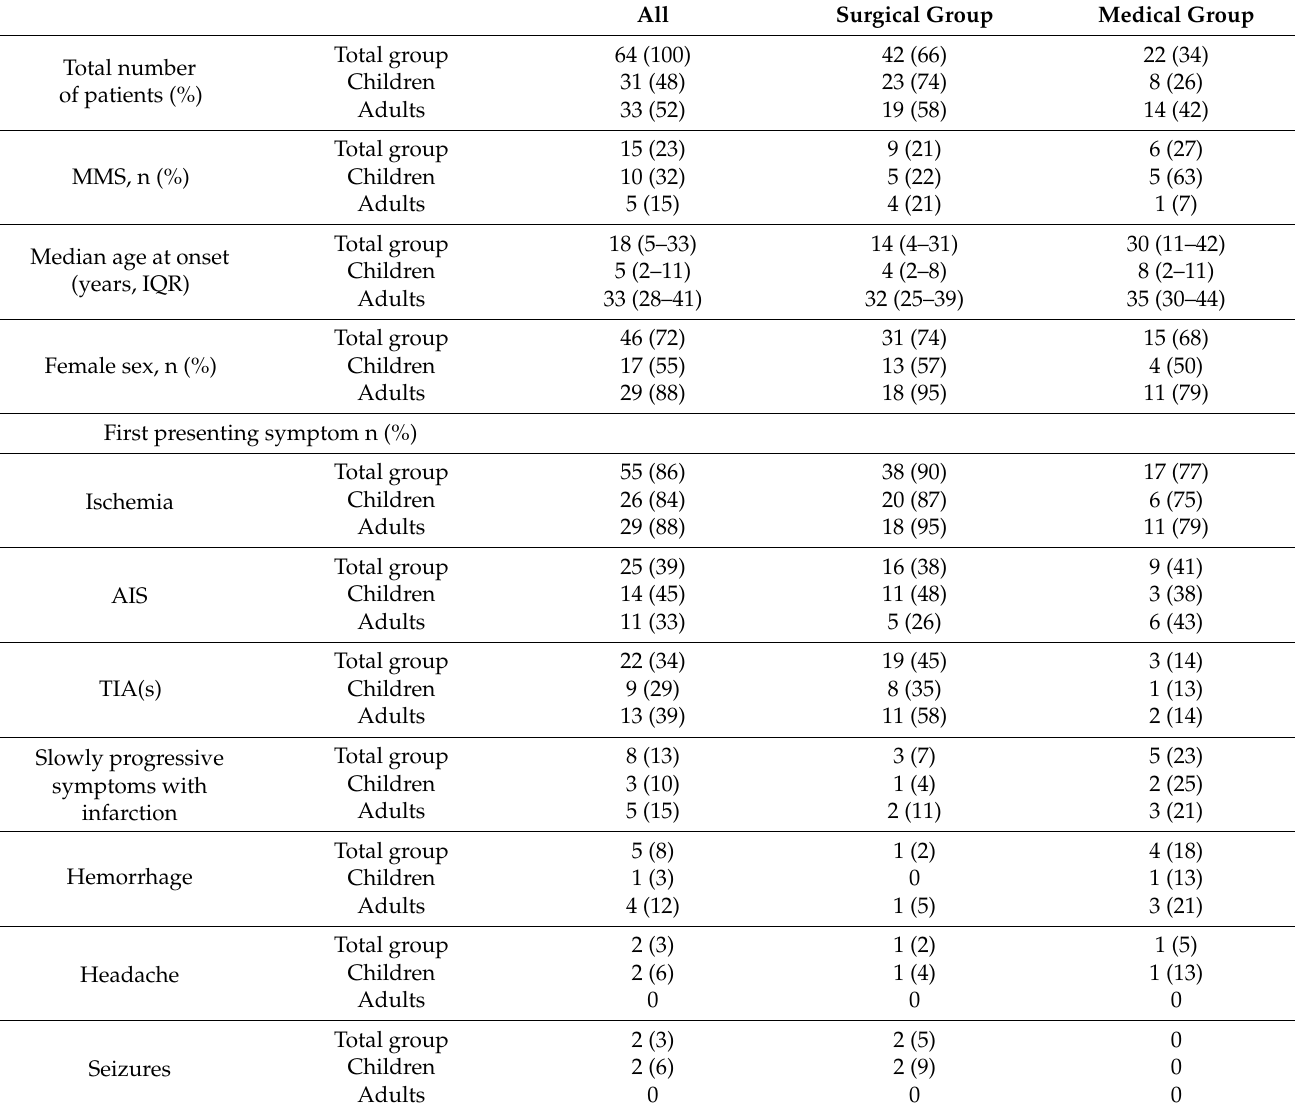
Table 1. Baseline characteristics of 64 patients with moyamoya vasculopathy. All Surgical Group Medical